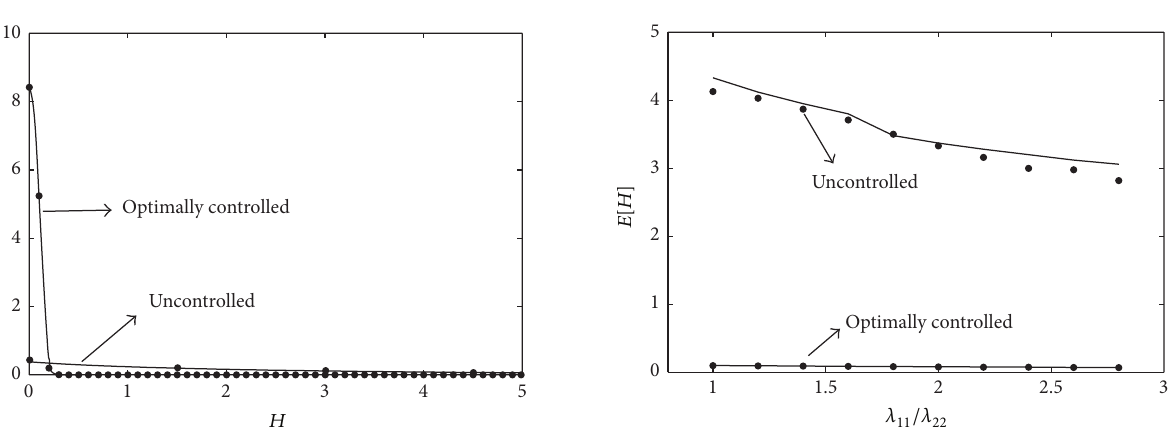
Figure 5: Stationary probability density 𝑝(𝐻) of total energy of uncontrolled and optimally controlled system (40). The lines are obtainedfromnumericalsolutionof(44)whilethedotsareobtained from direct simulation of original system (40).